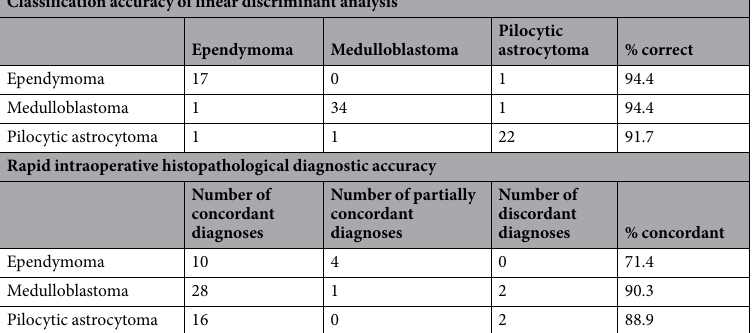
Table 2. The cross-validated diagnostic accuracy of the LDA for the three cerebellar tumor types. The linear discriminant classifier achieved accuracies greater than 90% for all three tumor types. Furthermore, for all tumor types, the classification accuracy was greater than the rapid intraoperative diagnostic examination; however, this appears to be due to partial concordance as opposed to an incorrect